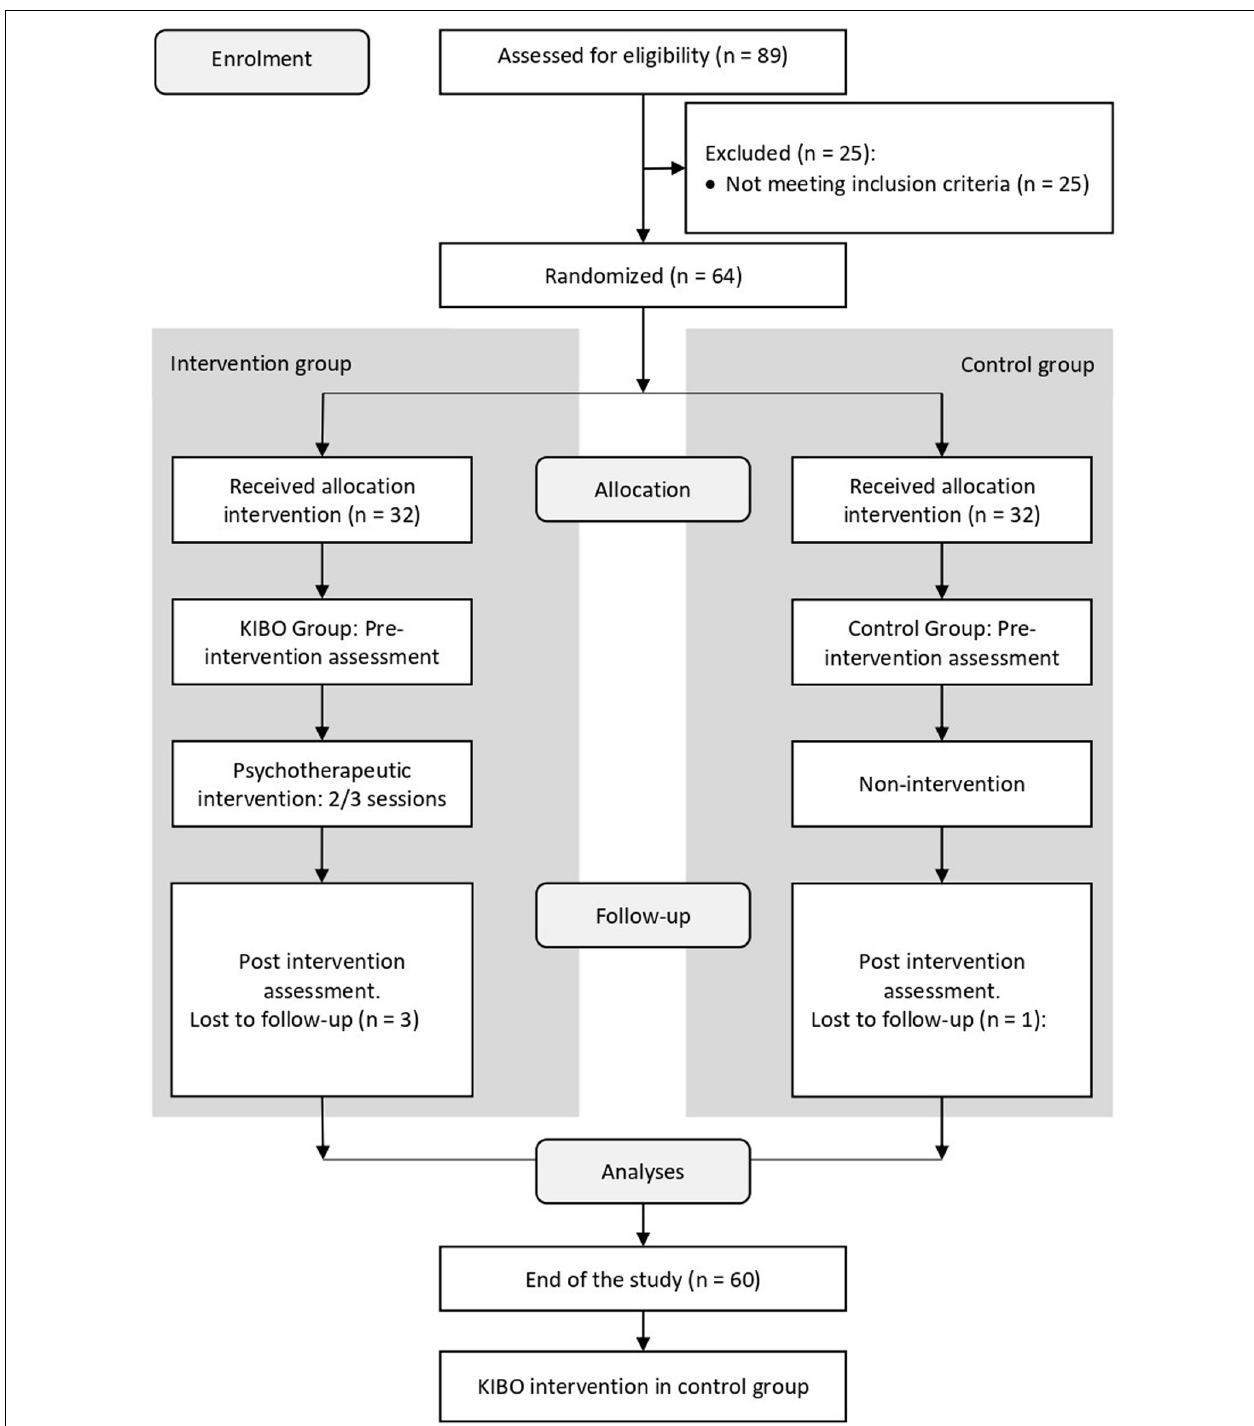
FIGURE 1 | CONSORT